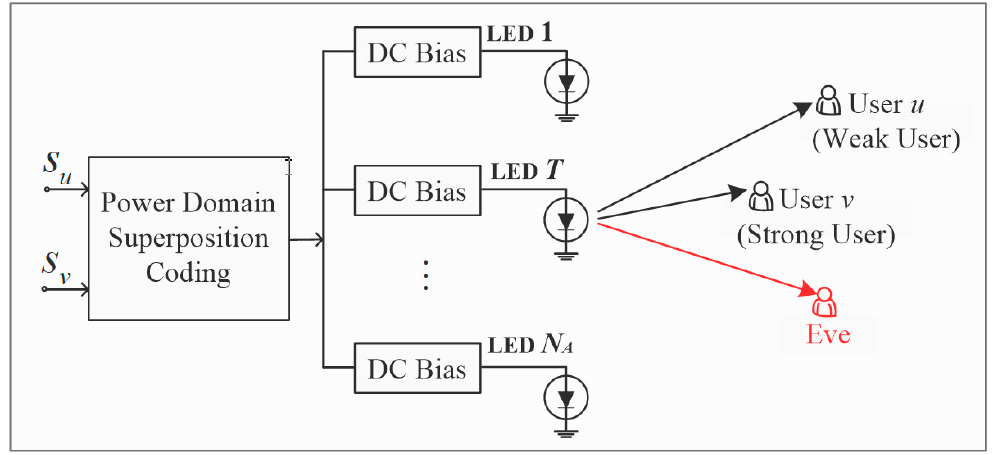
Figure 1. Multiple-input single-output non-orthogonal multiple access visible light communication (MISO-NOMA VLC) system